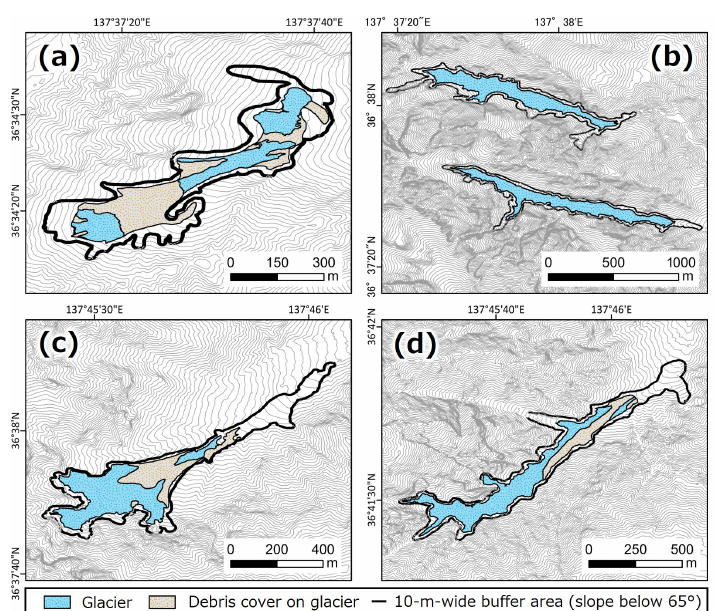
Figure 4. Glacier area and 10m wide buffer zone used for uncertainty estimate. (a) Gozenzawa. (b) Sannomado and Komado. (c) Kakunezato. (d) Karamatsuzawa. Contour interval is 10m.